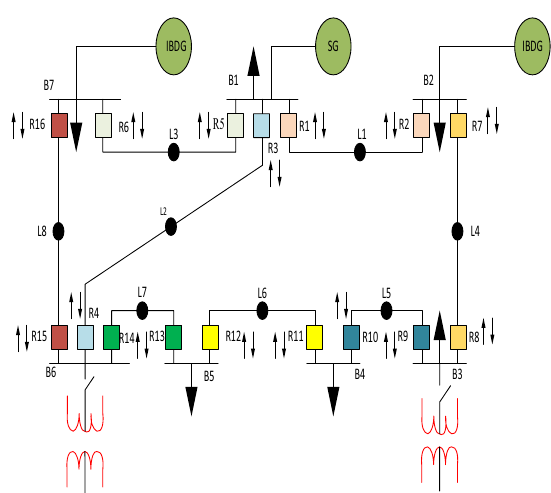
Fig. 4 Distribution part of IEEE-14 bus test system with dual setting DOCR